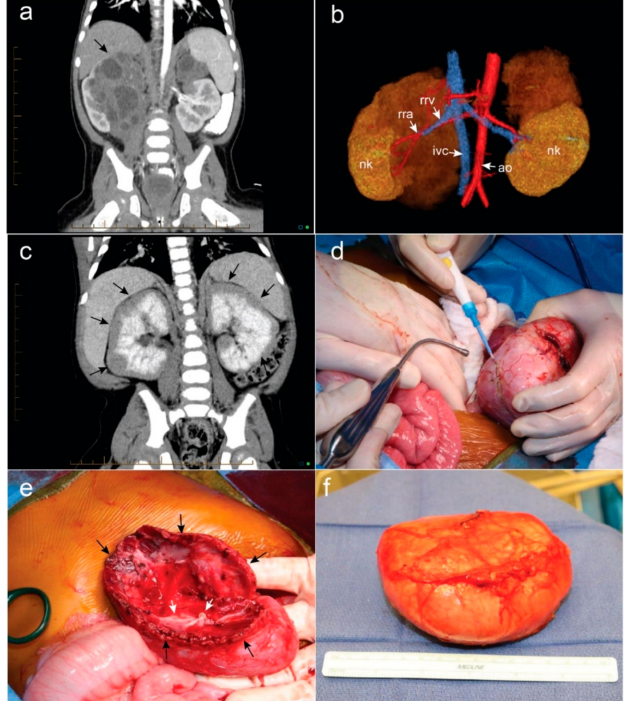
Figure 1. ( a ) Bilateral Wilms tumor (WT) demonstrating complex, ominous appearance of hilar right-sided tumor (black arrow) and more straightforward left-sided upper pole mass; ( b ) 3D rendering of bilateral tumors depicted in ( a ) assisted in delineating the vascular anatomy and bilateral nephron sparing surgery was possible. Nk = normal kidney, rra = right renal artery, rrv = right renal vein, ivc = inferior vena cava, ao = aorta; ( c ) bilateral diffuse hyperplastic perilobar nephroblastomatosis is depicted with rind-like peripheral expansion of nephrogenic rests (black arrows); ( d ) a marginal resection of bilateral WT is performed by developing the plane between the encapsulated tumor and normal renal parenchyma; ( e ) after nephron sparing surgery is performed, the collecting system (white arrows) is closed with monofilament suture. If possible, the redundant edges of normal renal parenchyma (black arrows) can be approximated over the raw surface of the kidney; ( f ) Appearance of the encapsulated WT following surgical